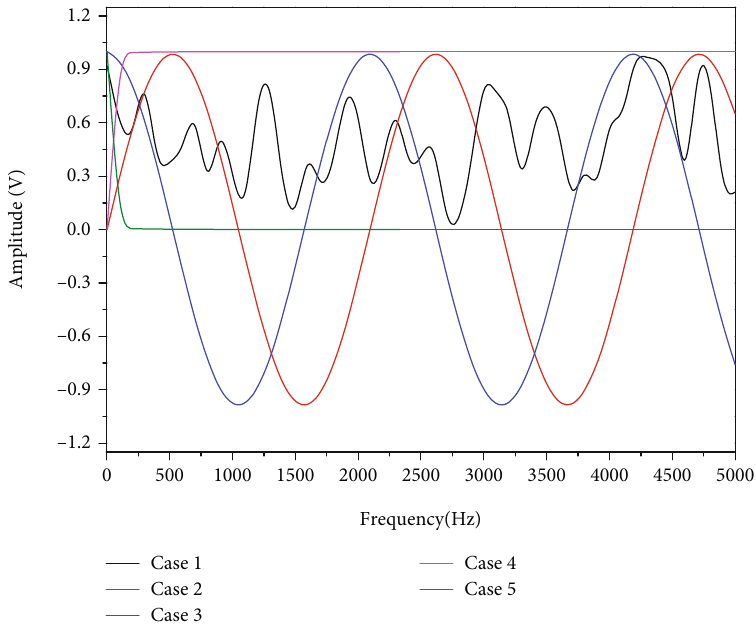
Figure 4: Spectrum analysis under two working